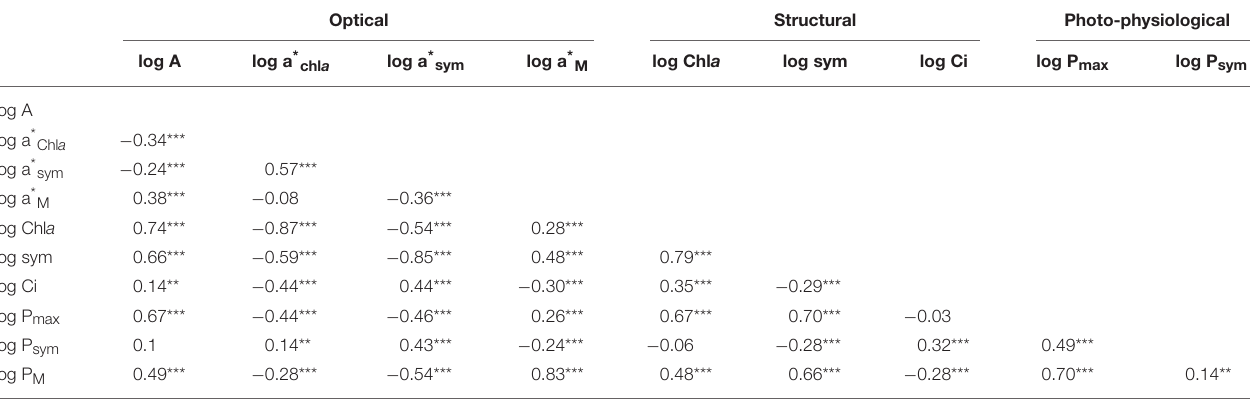
TABLE 4 | Pearson correlation between optical, structural, and photo-physiological descriptors. Optical Structural